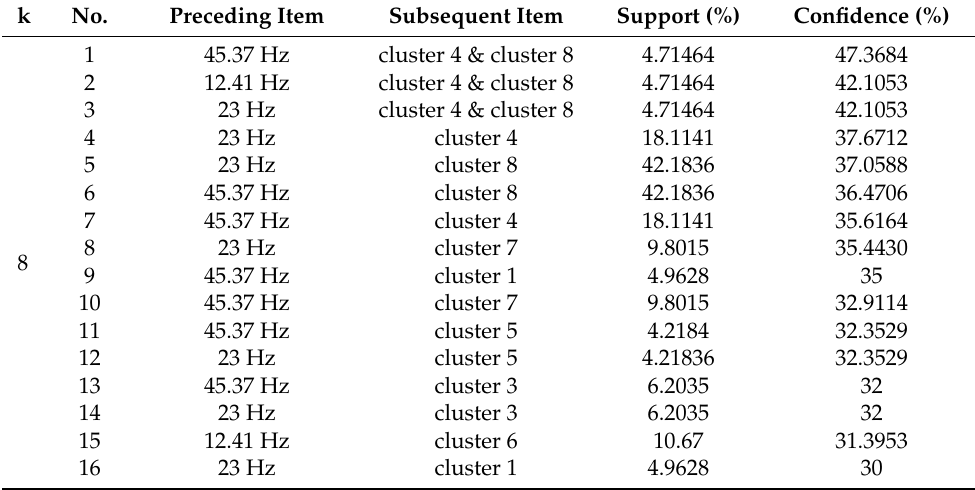
Table 7. Association rules (the adjacent data segments